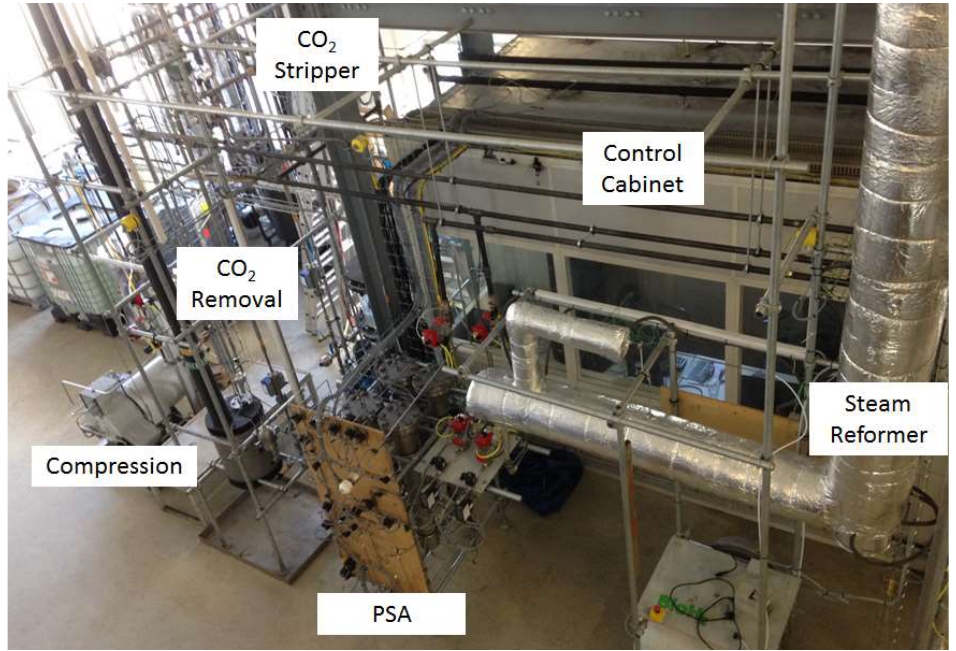
Figure 3. Photo of the gas upgrading and hydrogen purification part of the BioH 2 plant.